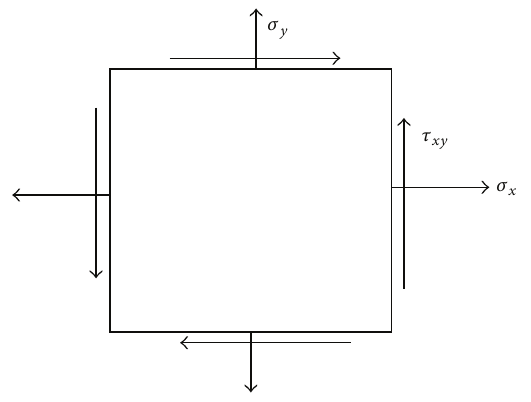
Figure 3: 2D stress components.